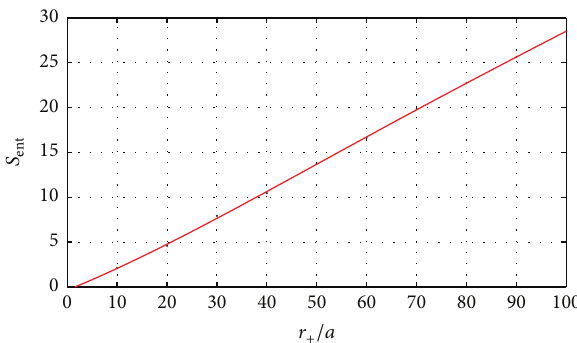
Figure 1: The entanglement entropy of massless fermion field with the function of 𝑟 + /𝑎 .